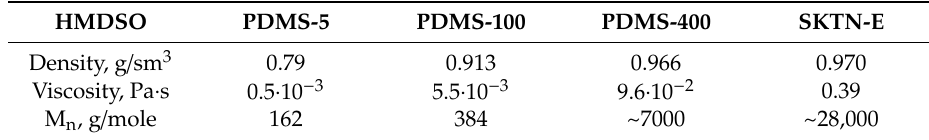
Table 1. The characteristics of the polydimethylsiloxanes under consideration